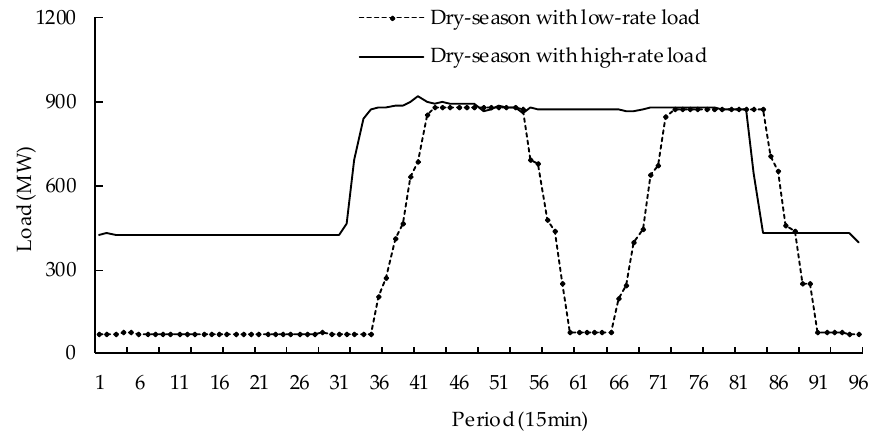
ff erent typical load